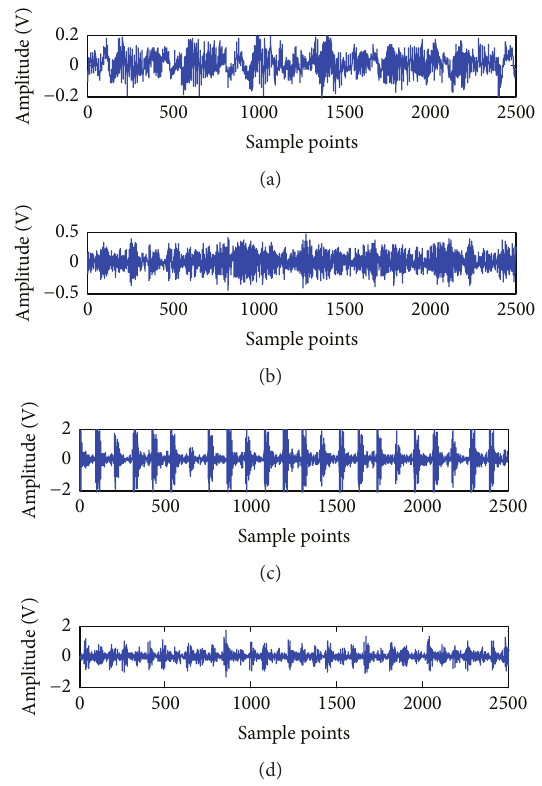
Figure 6: Vibration signal. (a) Normal. (b) Rolling element fault. (c) Outer race fault. (d) Inner race